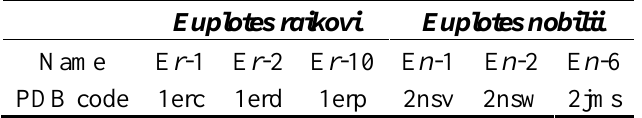
Table 1. List of the E n and E r pheromones investigated and corresponding PDB codes.